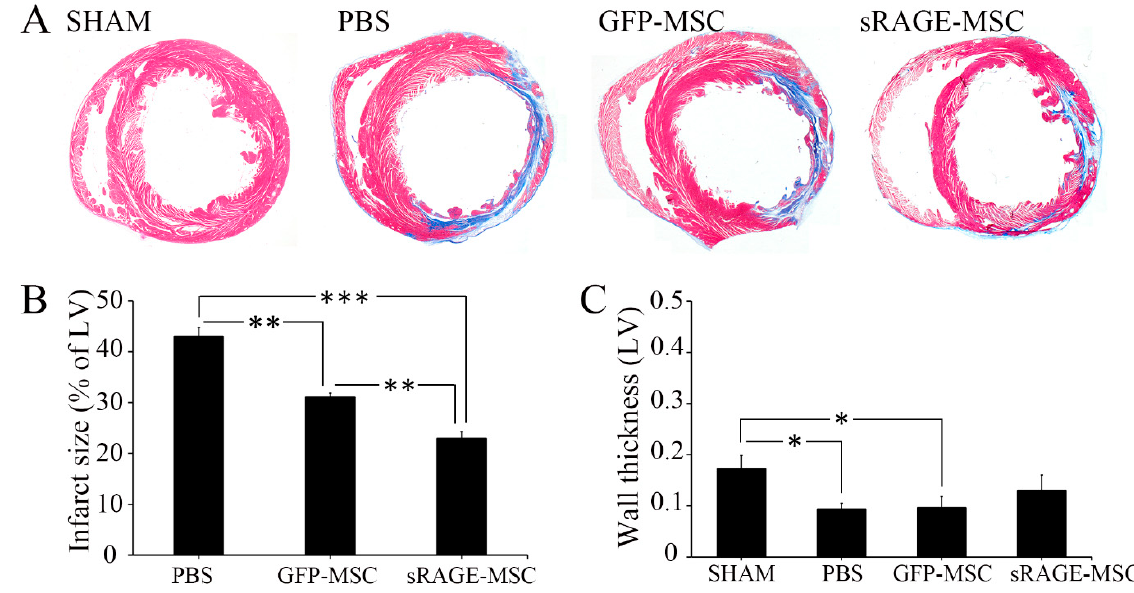
Figure 7. Soluble RAGE-secreting MSC protection of ischemia-mediated cardiomyocyte death by decreasing RAGE level. ( A ) Representative Masson’s trichrome staining revealed left ventricular fibrosis 4 weeks after AMI (magnification: 10X). Red color indicates viable myocardium; blue color indicates fibrosis due to infarction damage. ( B ) Infarct size was expressed as a percentage of ischemic area ( C ) and as the length of wall thickness; *, p < 0.05; **, p < 0.01; ***, p < 0.001.